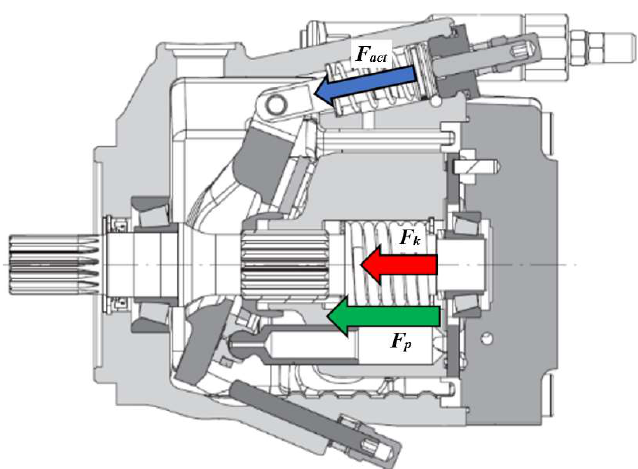
Figure 5. Sectional view of the pump with indicated the forces acting on the swash plate.